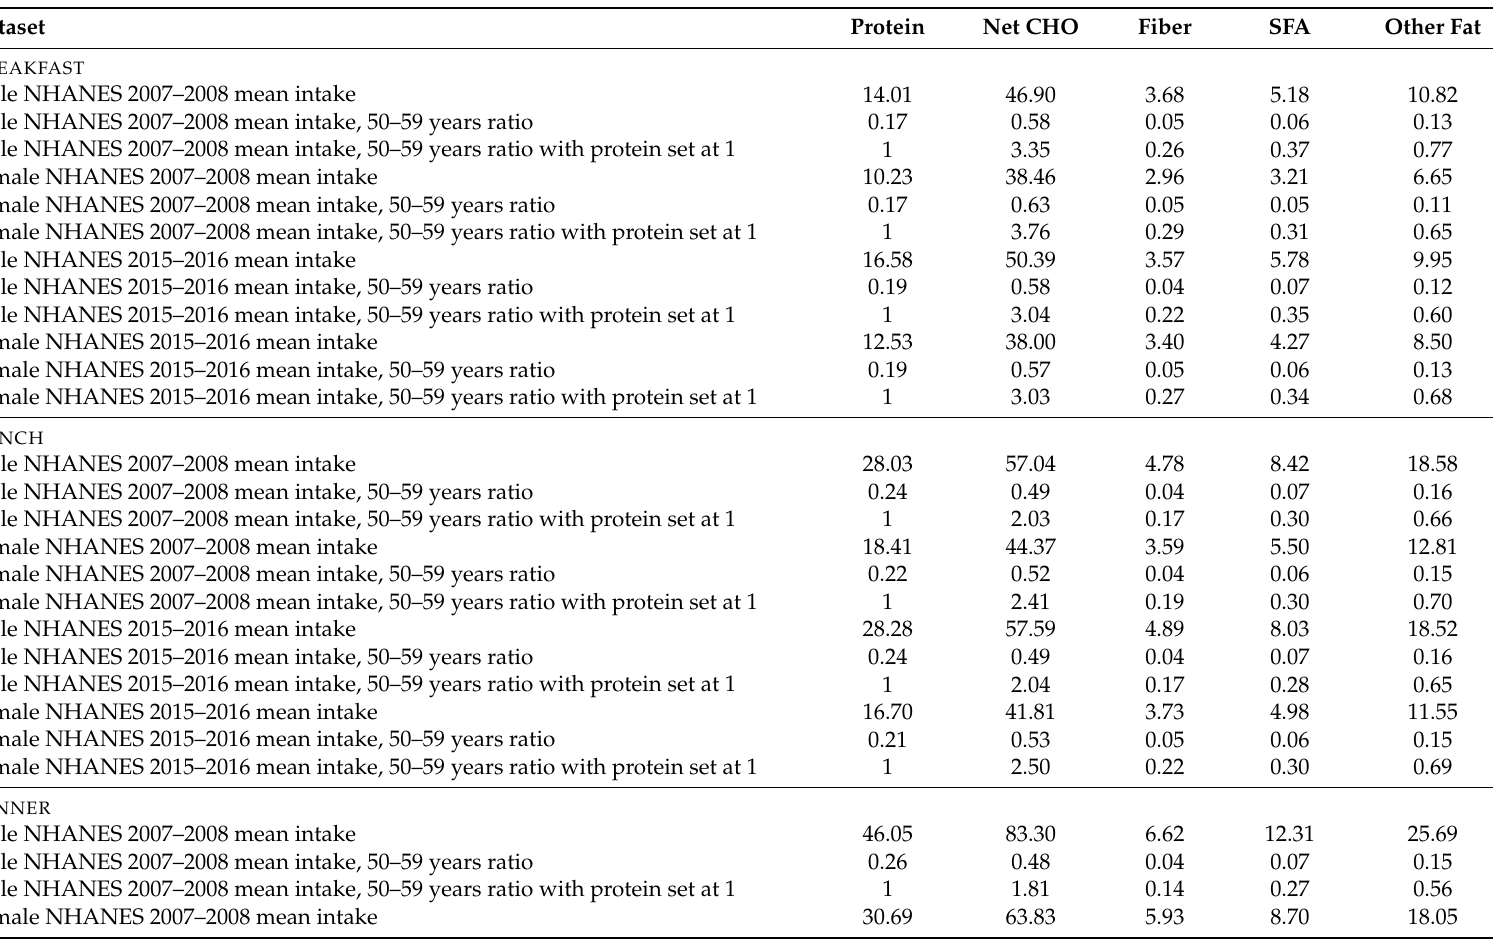
Table 4. Macronutrient intakes (derived from the National Health and Nutrition Examination Survey (NHANES) 2007–2008 and 2015–2016 data) their ratios, and their ratios relative to protein at meal occasions for males and females 51–59 years of